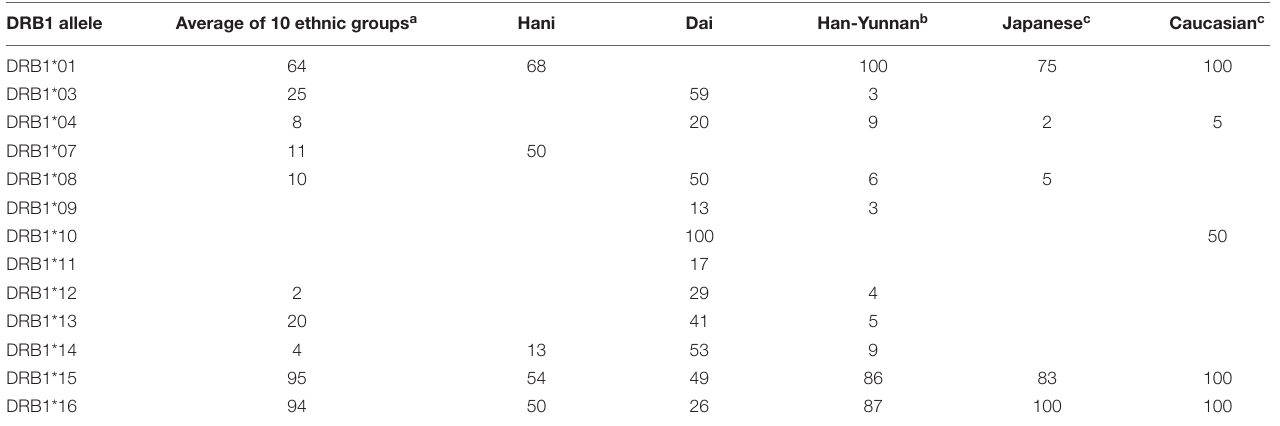
TABLE 5 | Percentage association between HLA-DRB1 alleles and AluDRB1. DRB1